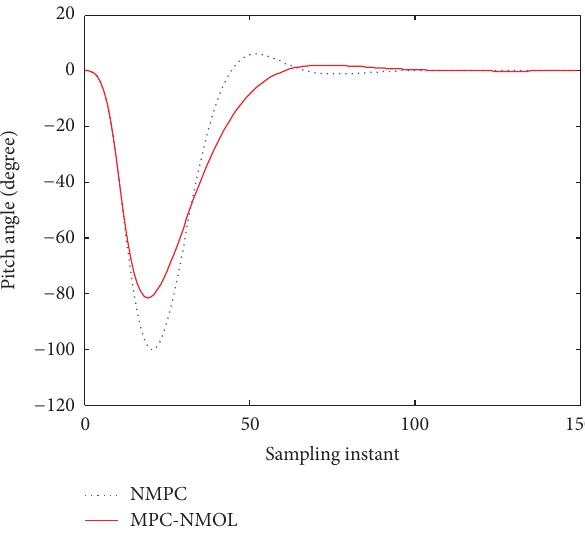
Figure 4: Comparison of depth with no disturbance.